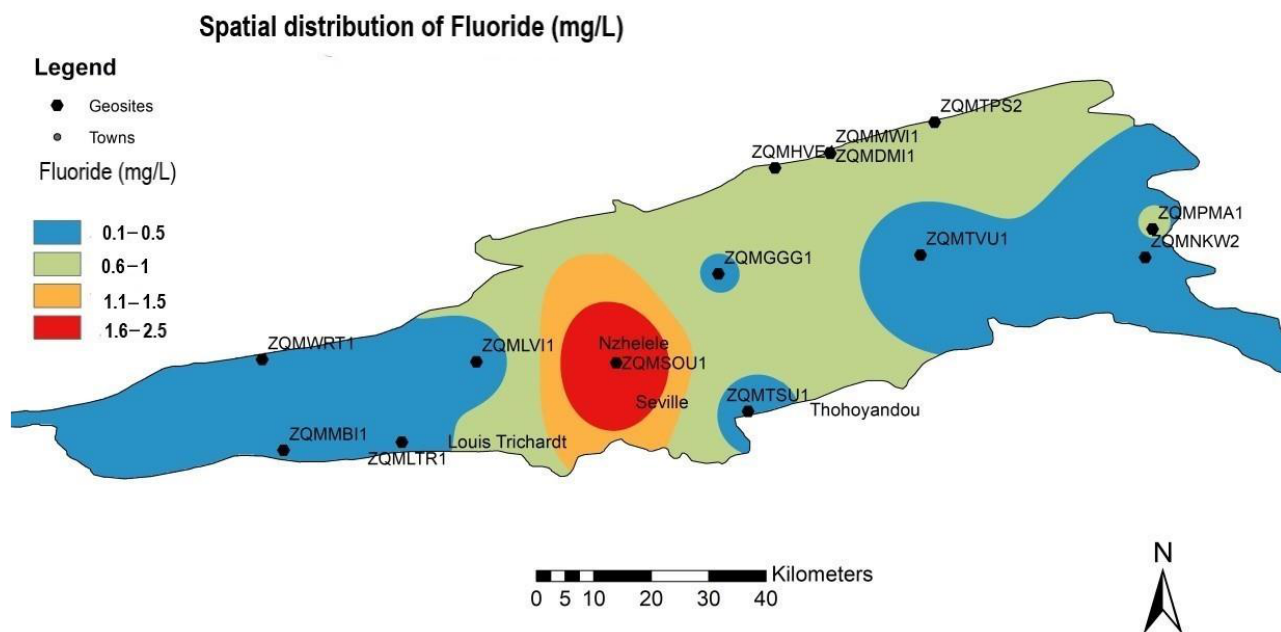
Figure 3. Spatial distribution of nitrate in the Soutpansberg region.